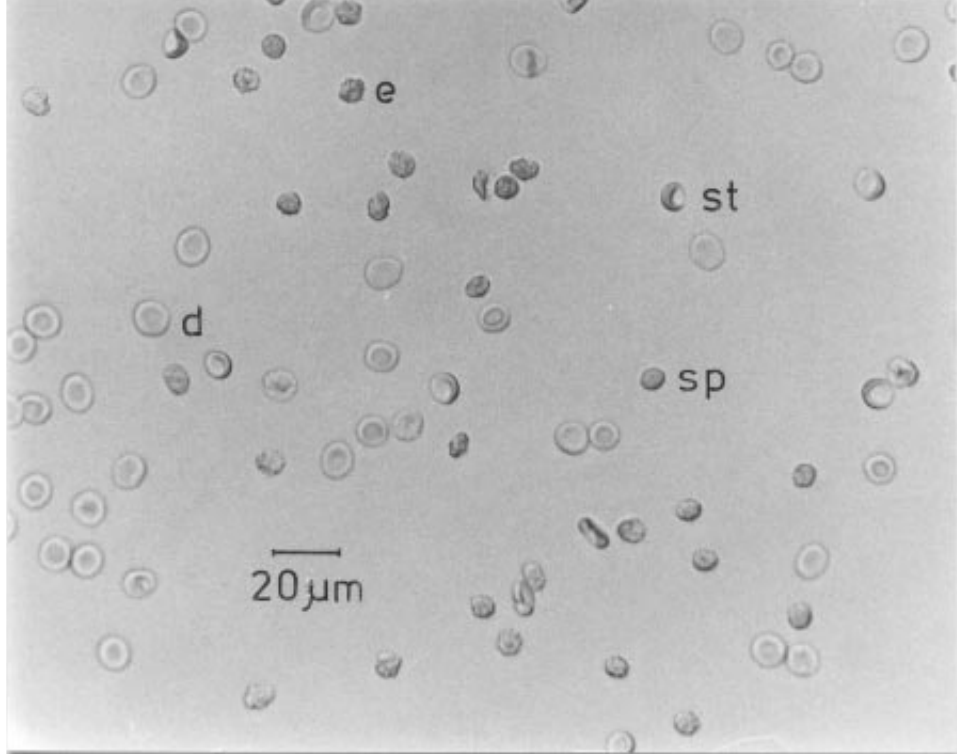
Figure 1 - Photomicrograph of human erythrocytes preserved in ADSOL for 5 weeks at 4 o C. d, Discocyte; e, echinocyte; st, stomatocyte; sp,